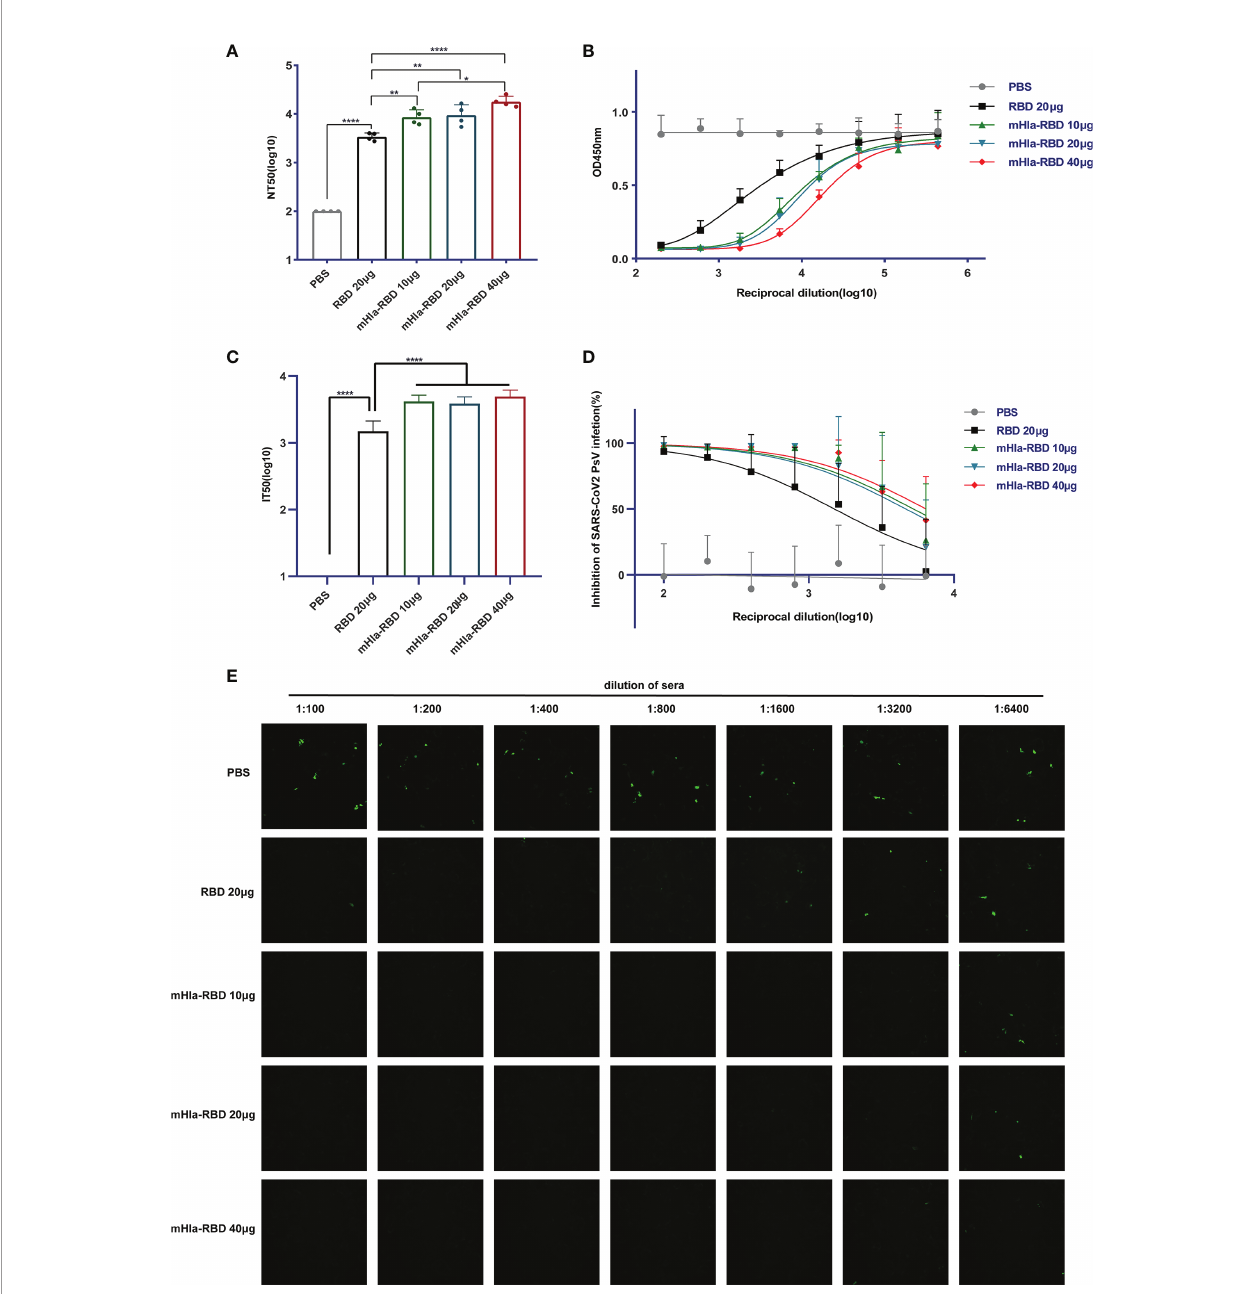
FIGURE 5 | Neutralizing antibodies assay. (A) ELISA blocking assay. One-way ANOVA with Tukey ’ s multiple comparisons, * p < 0.05, ** p < 0.01, **** p < 0.0001. (B) Relative amount of RBD-HRP binding to hACE2 after blocking sera from immunized BALB/c mice with different dilutions. (C) Wild-type-spike pseudovirus neutralization assay. Two-tailed unpaired Student ’ s t-test, **** p < 0.0001. (D) Inhibition of wild-type-spike pseudovirus infection by sera from immunized BALB/c mice. (E) Presentative images of wild-type-spike pseudovirus infection blocked by serial dilution of sera from immunized BALB/c